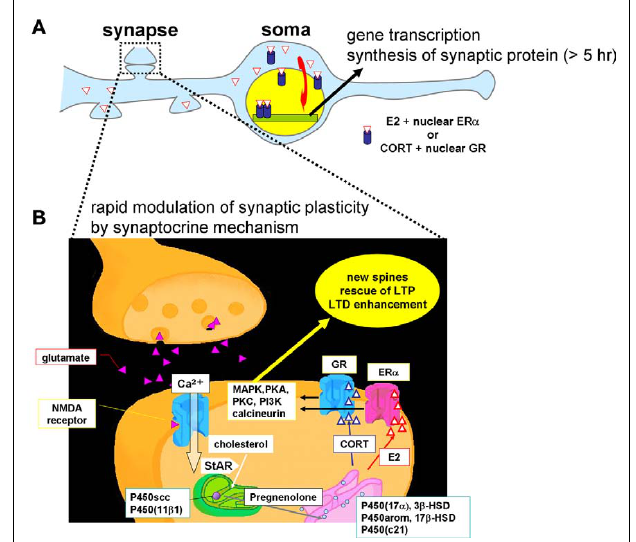
FIGURE 11 | Schematic illustration of synaptic actions by hippocampus-synthesized steroids. (A) Slow modulation of synaptic plasticity via gene transcription and synthesis of synaptic proteins in neurons.The delayed action of E2 or CORT is mediated by ER α /ER β or GR in cytoplasm and nuclei, respectively. New synaptic connections are formed by synthesized synaptic proteins or neurotrophic factors. (B) Rapid modulation of the synaptic plasticity via synaptic ER α and GR. Hippocampal neurons synthesize much higher level of E2 than that from circulation.The level of hippocampus-synthesized CORT is in the order of 10nM which is sufficient to increase density of dendritic spines. Upon Ca 2 + influx via NMDA receptor, transport of cholesterol to inner membrane of mitochondria by StAR is facilitated, resulting in enhancement of steroid synthesis. P450scc and P450 (11 β 1) are localized in mitochondria and P450 (17 α ), 3 β -HSD, P450arom, 17 β -HSD, and P450 (c21) are localized in endoplasmic reticulum. Hippocampus-synthesized sex steroids and corticosteroids bind to synaptic ER α and GR which drive signal cascades mediated via various kinases and